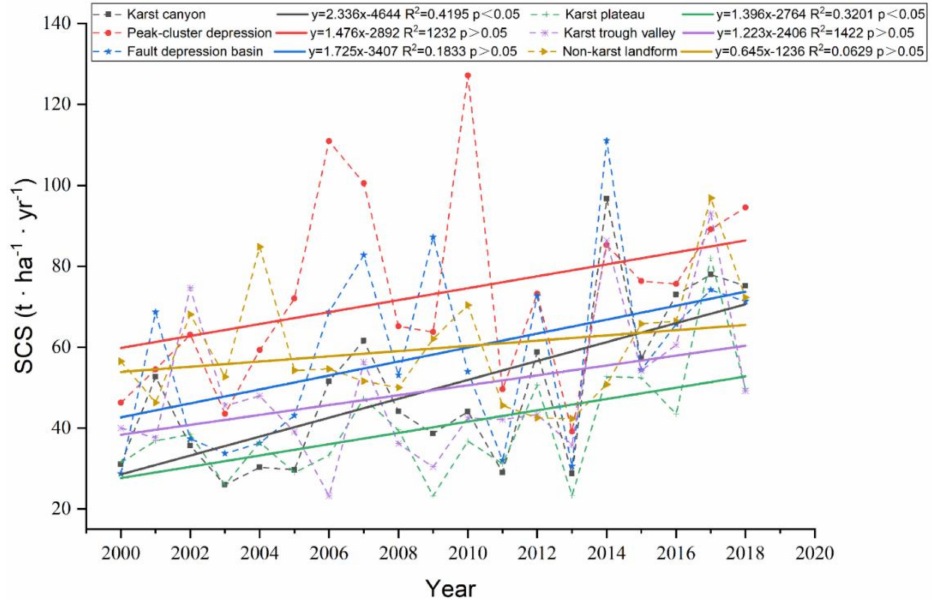
Figure 8. Interannual trend of temporal variation of SCS in di ff erent landform regions on the Guizhou Plateau (2000–2018).